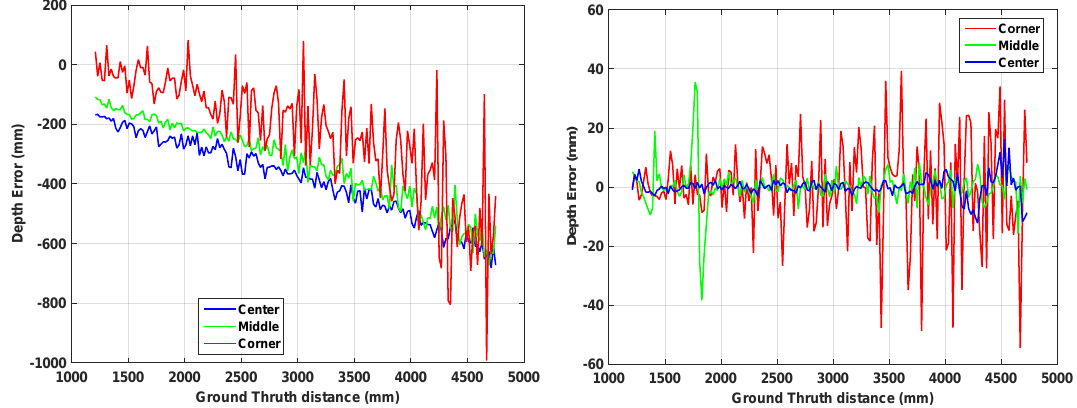
Figure 6. Linearity error, raw data (left) and per pixel corrected (right).